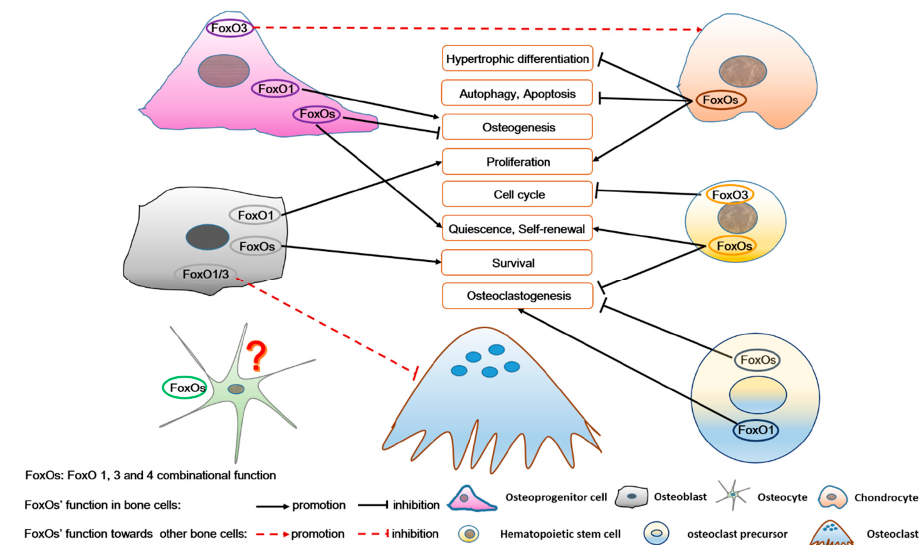
Figure 6. The role of FoxOs in osteoprogenitor cells, chondrocytes, osteoblasts, osteocytes, hematopoietic stem cells, and osteoclast precursors, as well as in the complex intercellular signaling among these bone cells. FoxOs not only regulate survival, self-renewal, cell cycle, proliferation, differentiation, autophagy, and apoptosis of bone cells, but also participate in the interaction among these bone cells. FoxO’s function in osteocytes is unknown.